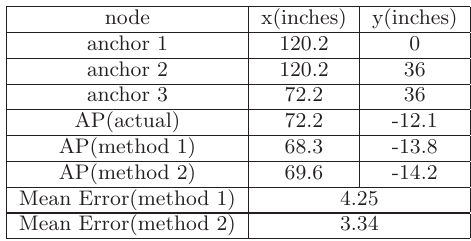
Table 8: Indoor Location Estimation